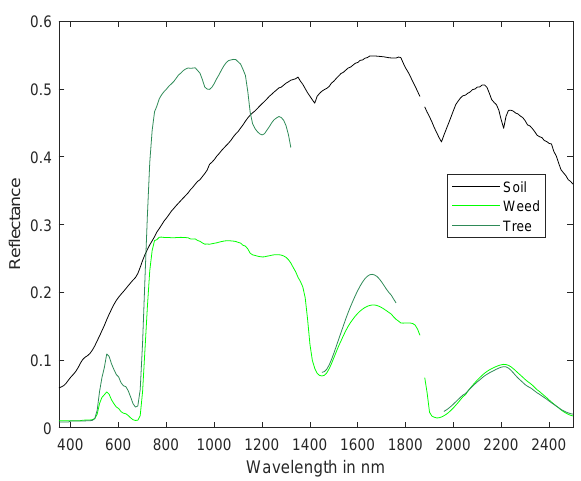
Figure 3. Endmember spectra of soil, weed, and citrus tree of the ray tracing experiment.